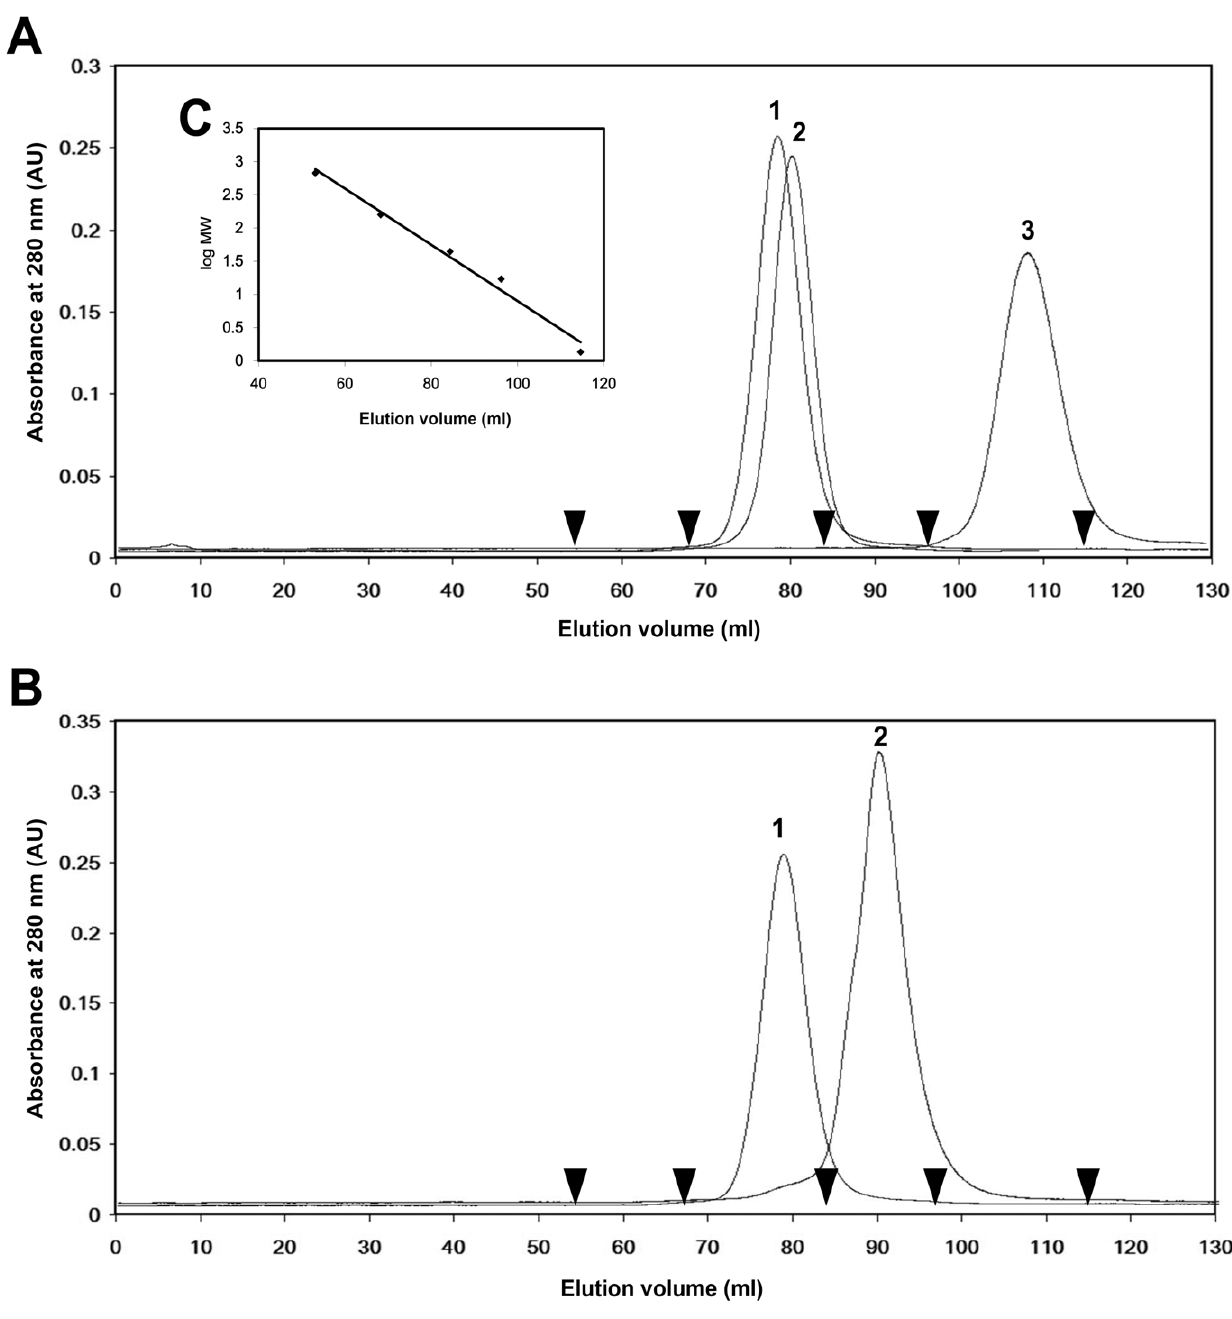
Figure 4. Determination of tetrameric IPO by gel-filtration chromatography. The HiLoad TM 16/60 Superdex TM 200 column was pre- equilibrated with a running buffer containing 27 mM Tris-HCl (pH 7.0) and 2 M NaCl with and without 0.2 M Me-Glc or 1 M glucose at a flow rate of 0.6 ml/min. The elution profiles were monitored at 280 nm. ( A ) Peak 3 represents the IPO protein dissolved in the running buffer without carbohydrates and eluted at 108.2 ml. Peak 2 represents the IPO protein dissolved in the running buffer with 0.2 M Me-Glc and eluted at 80.5 ml. Peak 1 represents the IPO protein dissolved in running buffer with 1 M glucose and eluted at 78.8 ml. The retarded results from peaks 1 and 2 show that the IPO protein could bind to the dextran of the Superdex 200 column. The retarded phenomenon of IPO could be complemented by 1 M glucose. Peak 3 was found with an estimated molecular mass of 63.2 kDa corresponding to a tetramer with 69.2 kDa. ( B ) To determine the role of the N terminus of IPO protein in tetramerization, a truncated IPO by removing residues 1 to 10 was prepared. The proteins were dissolved in the running buffer with 1 M glucose. Peak 1 represents the native IPO and was eluted at 78.8 ml. Peak 2 represents the truncated IPO and was eluted at 89.6 ml. Peak 2 was calculated with a molecular mass of 22.0 kDa corresponding to a truncated monomer with 16.3 kDa. ( C ) The standard markers from BioRad containing thyroglobulin (670 kDa), gamma-globulin (158 kDa), ovalbumin (44 kDa), myoglobin (17 kDa), and vitamin B12 (1.35 kDa) were used to calculate the equation of linear regression. The X-axis represents the elution volume and Y-axis the log value of molecular mass from the standard markers. The equation is y=-0.0423x + 5.1333 and R 2 =0.9847.